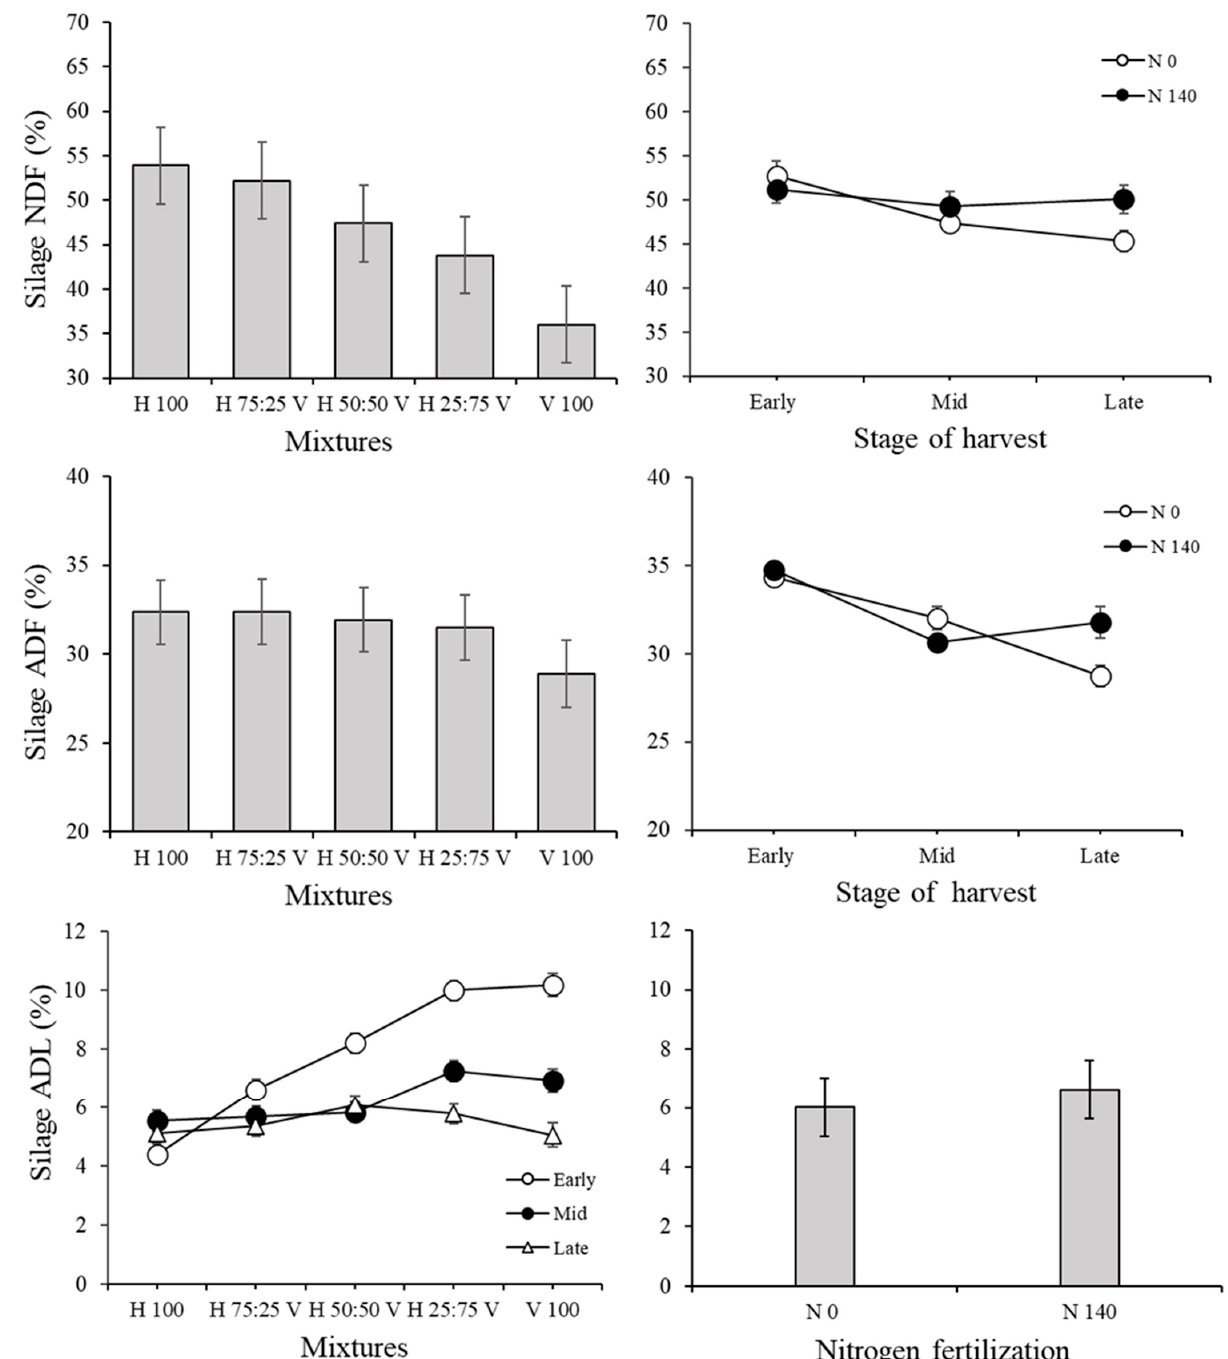
Figure 11. Silage NDF concentration ( above ) as affected by MX mean effect ( left ) and SH × MX interaction ( right ). Silage ADF concentration ( middle ) as affected by MX mean effect and SH × MX interaction. Silage ADL concentration ( below ) as affected by SH × MX interaction ( left ) and NF mean effect ( right ). On the left, values are LSmeans across all treatments along with standard error estimate of the LSmeans since the design was unbalanced between the faba bean crop ( n = 9) compared to the mixtures and the barley crops ( n = 18). On the right, only data of the barley-containing treatments were used. Each point represents the arithmetic mean ( n = 24) and its computed standard error concentration was mostly reduced by reducing the fraction of barley in the mixture. Moreover, the variable was affected by the interaction SH × NF: unfertilized treatment.